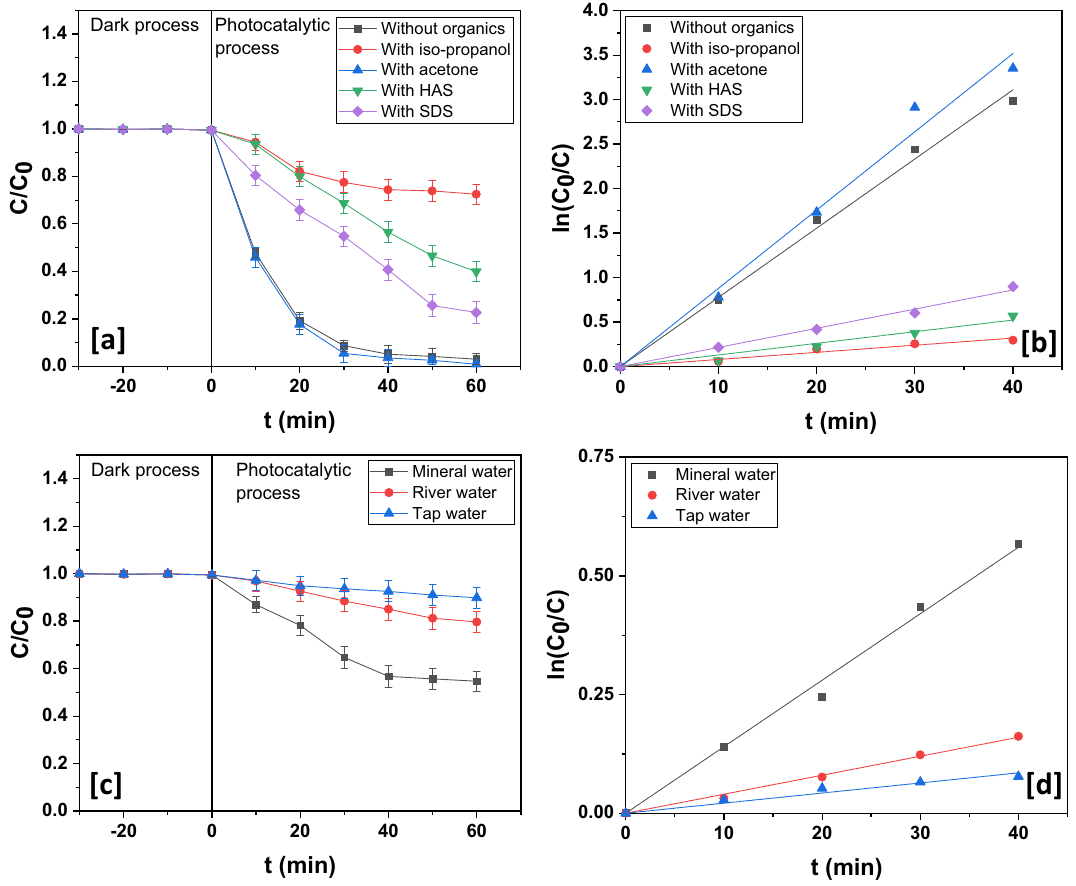
Figure 16. ( a ) Dynamics and ( b ) kinetics profile in presence of different organics. ( c ) Dynamics and ( d ) kinetics profile in various water